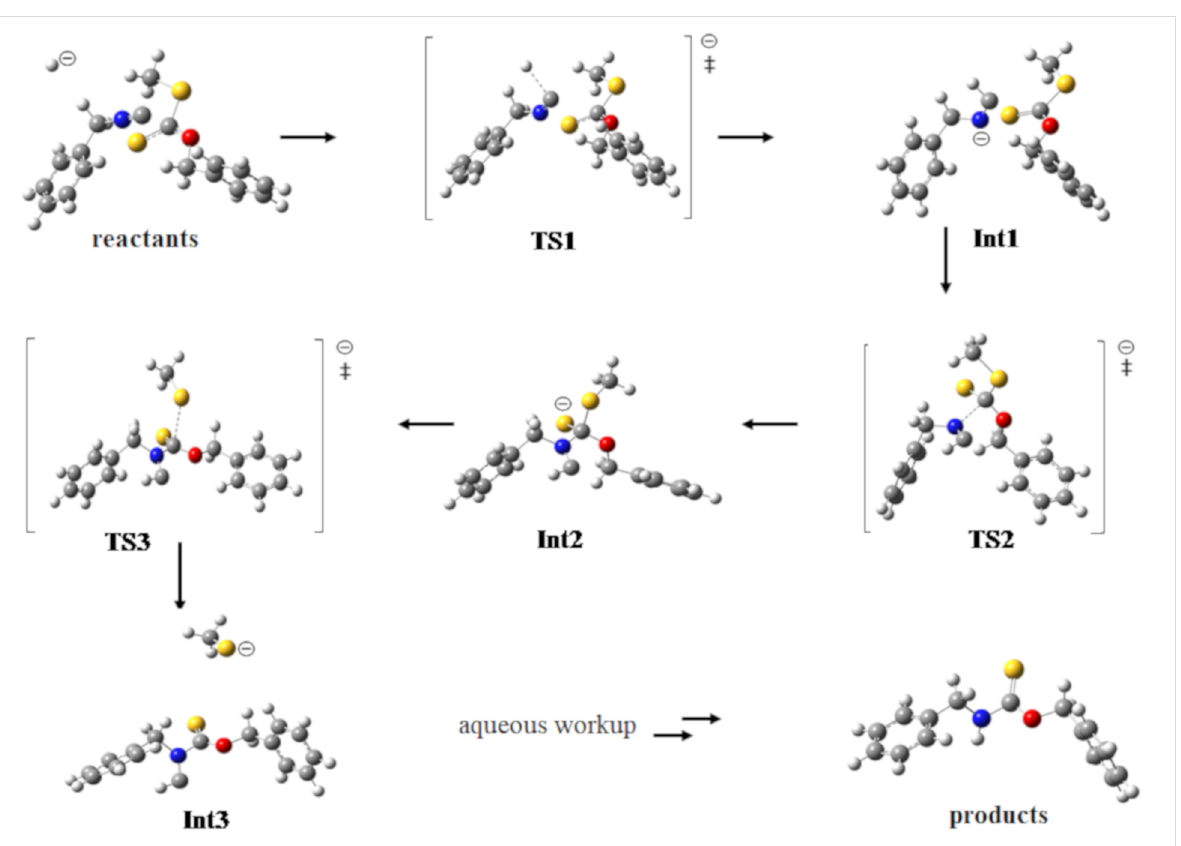
Figure 4: Optimized geometries of the reactants, transition states, intermediates, and products of the proposed reaction mechanism, as shown schematically in Scheme 2, determined at the B3LYP/6-311++G(d,p) level of theory in DMF (using a